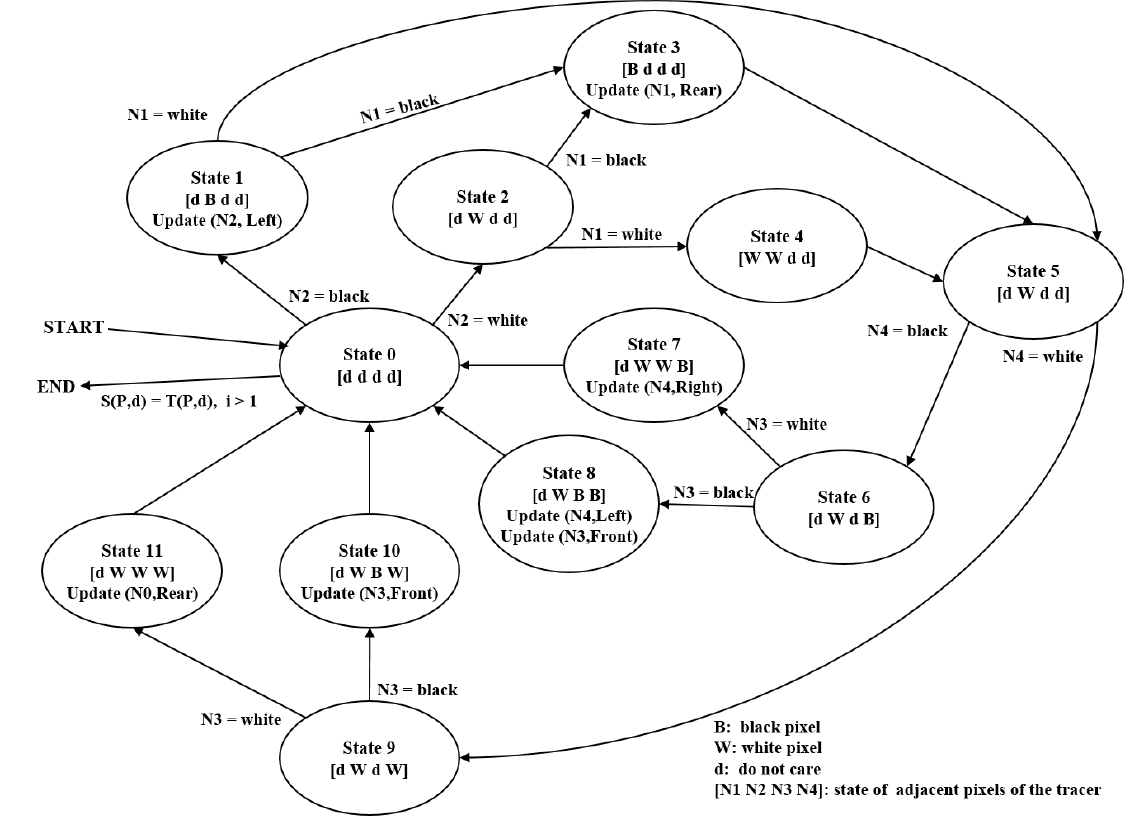
Figure 10. State transition of automation for the proposed